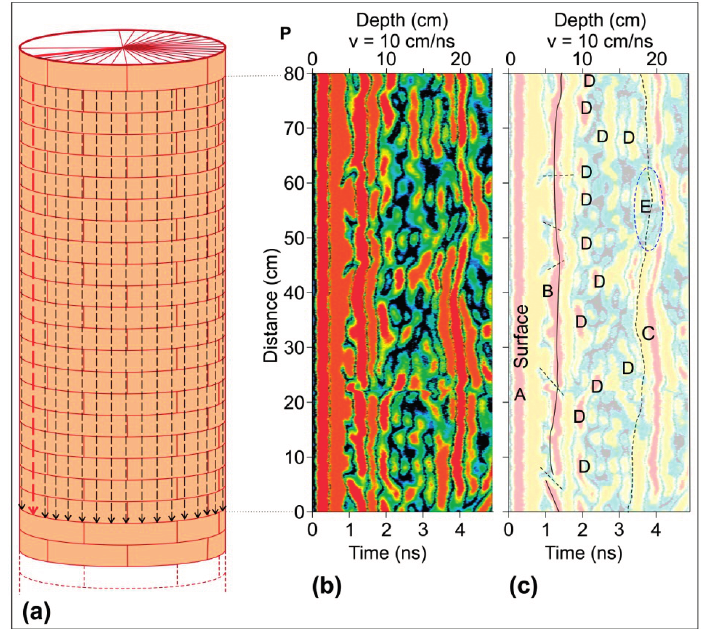
Figure 5. Distribution of the vertical radar lines on the column ( a ) and one of the radar images obtained in the profile (P) ( b ); four main detected anomalies are marked on the radar data interpretation, shown in ( c ): A: reflection on the surface of the column;